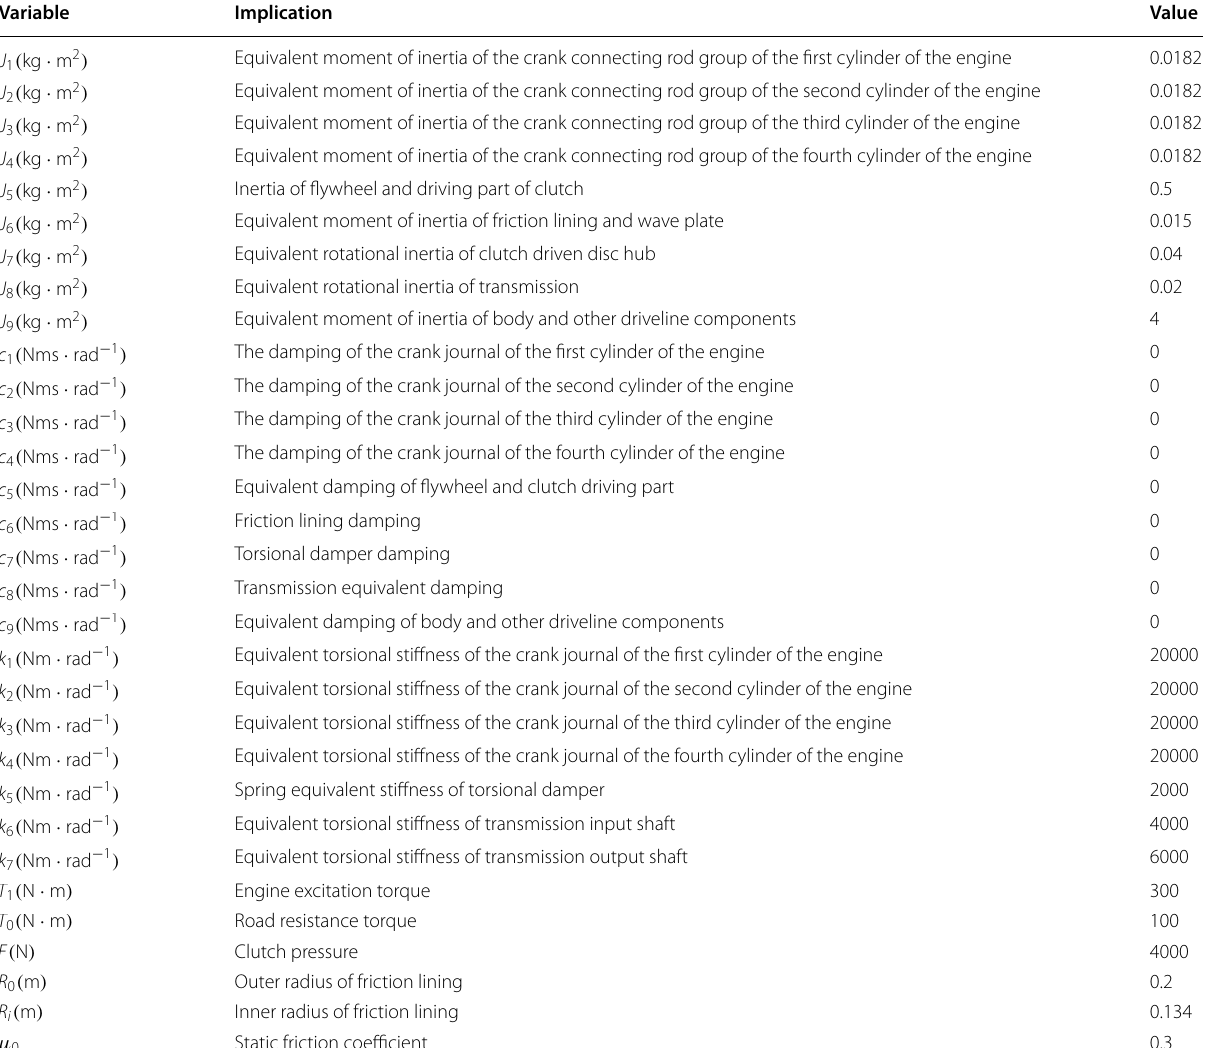
Table 1 Parameters of a vehicle